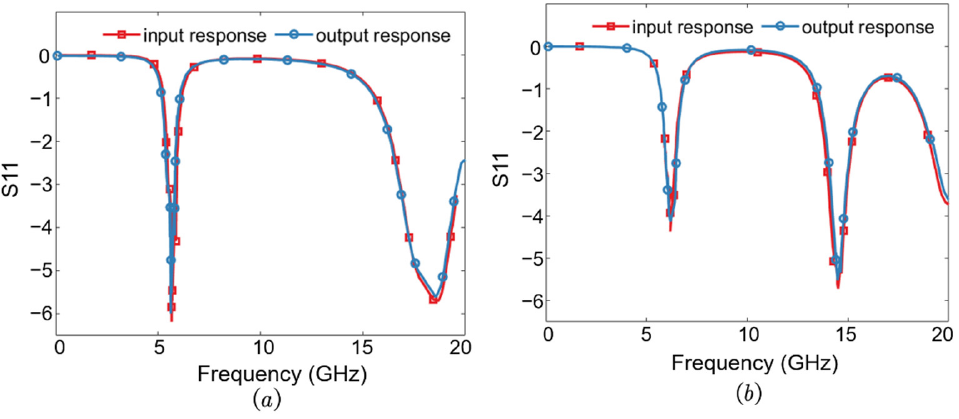
Figure 9. ( a , b ) Diagram of input response and output response of network 1.